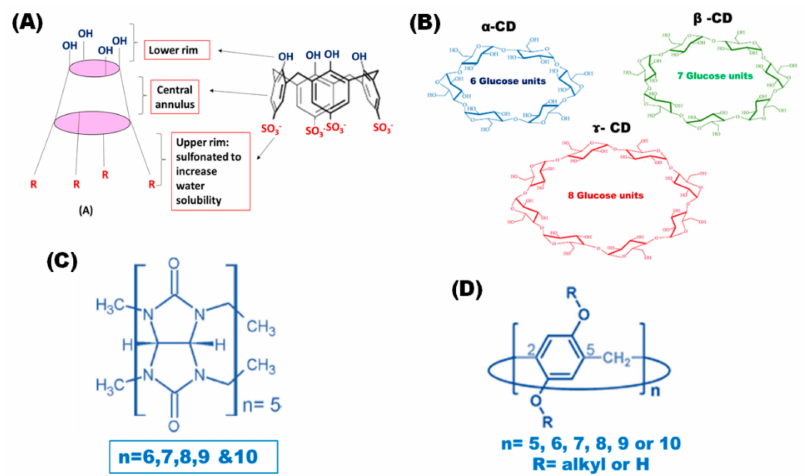
Figure 1. Chemical structure of calixarenes (CXs) and sulfonated CXs ( A ), cyclodextrins (CDs) ( B ) cucurbiturils (CBs) ( C ) and pillar[n]arenes ( D